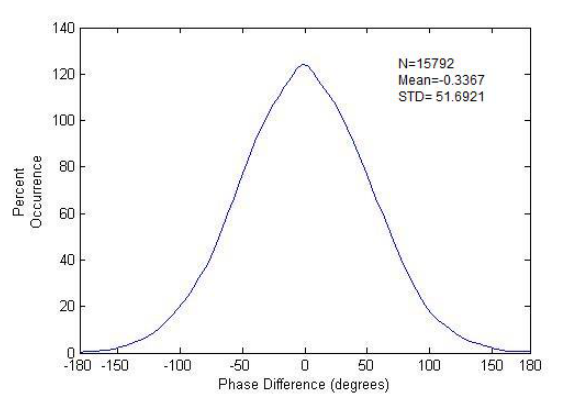
Figure 1. PPD distribution for the near-range of FQ4 The standard deviations that represents the variability in assignable to the permanence of the measurement system, for two images is almost the same.